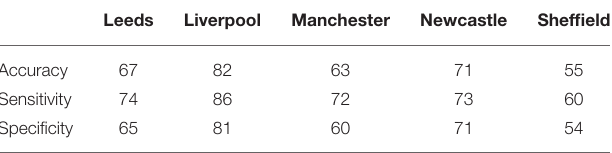
TABLE 5 | By-city classification